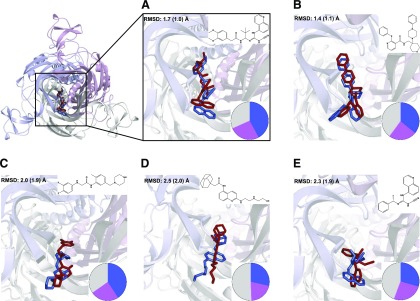
Redocking of allosteric antagonists into pdP2X7R using RosettaLigand. (A) A740003, (B) JNJ47965567, (C) GW791343, (D) AZ10606120, and (E) A804598. (A–E) Reference antagonist poses from X-ray structures 5U1U (A), 5U1X (B), 5U1Y (C), 5U1W(D), and 5U1V(E) are shown as blue sticks. For each antagonist one representative pose from each of the two main clusters in the redocking process was selected. From these two the pose closest to the X-ray structure is shown as red sticks. Pie charts indicate the size of two main clusters from the respective docking run (marine and magenta) with the remaining poses colored in gray. Root-mean-square deviations (rmsd) between the representative docked pose and antagonist in X-ray structures are given in the top left of each panel. The values in brackets refer to the pose with the smallest rmsd within the selected cluster. The pdP2X7R structure is shown in cartoon representation with the three subunits shown in gray, light blue, and pink.